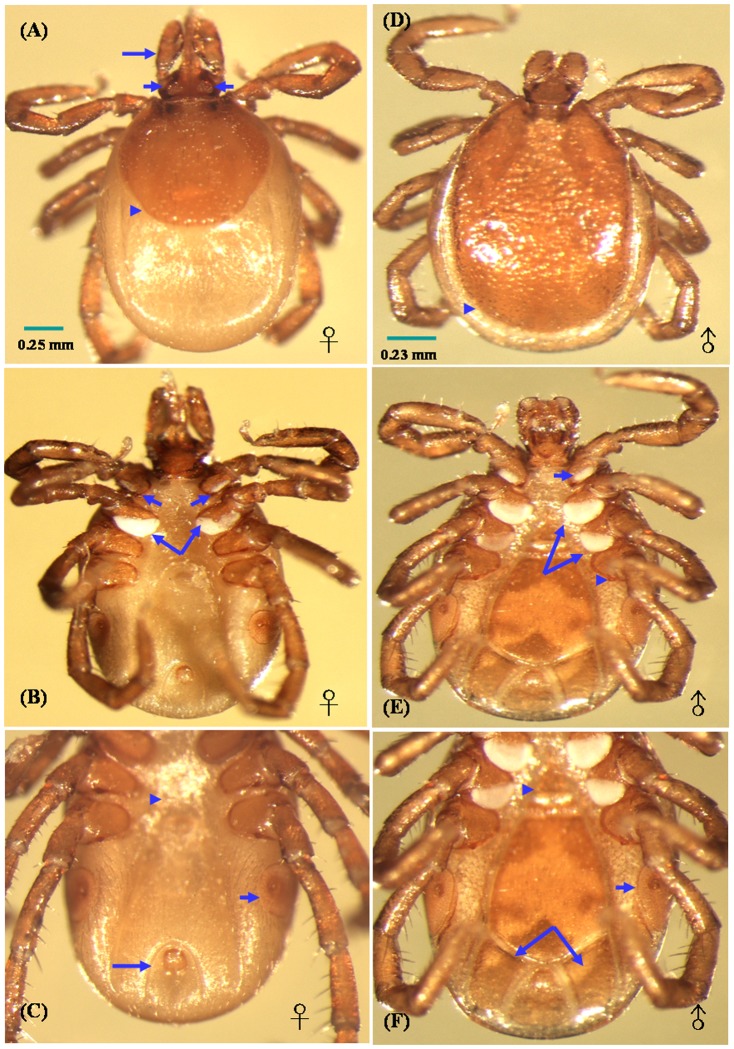
Light micrographs of female (A, B, and C) and male (D, E, and F) Ixodes ovatus ectoparasitized on cat in Taiwan.
A, Dorsal view of female tick showing one pair of long palp (long arrow), oval porose areas (short arrows) situated at the subpentagonal basis capituli and the oval-shaped scutum covered on a half of abdomen (arrowhead); B, Ventral view of female tick showing a special transparent membrane-like structure (white sheet) covered on a third of coxae I (short arrows) and two third of coxae II (long arrows); C, The genital aperture (arrowhead) is situated at a level between coxae III and IV. Laterally, the rounded spiracular plates (short arrow) contain large maculae. The oval-shaped anal groove (long arrow) encircled around the anus with a posterior opening was situated at the end of abdomen; D, Dorsal view of male tick showing the oval-shaped scutum covered on full-abdomen (arrowhead); E, Ventrally, coxae IV of male tick possess short, distinct external spurs (arrowhead), and coxae I–III was characterized with a special transparent membrane-like structure (white sheet) covered on a third of coxae I (short arrow), two third of coxae II and a half of coxae III (long arrows); F, The genital aperture (arrowhead) is situated at level between coxae III. Laterally, the oval-shaped spiracular plates (short arrow) contain small maculae. The adenal plates (long arrows) paralleled with the anus were only observed on male tick.